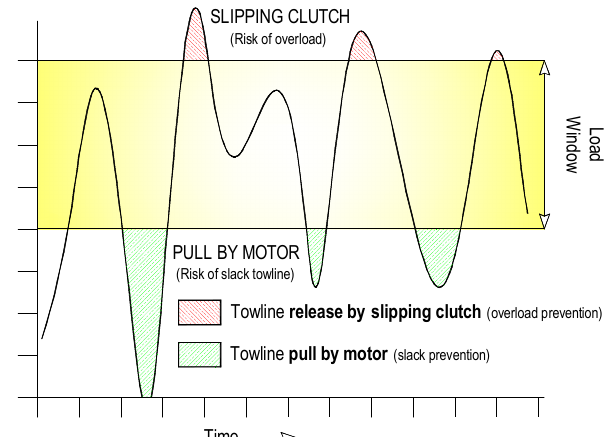
Figure 10. Typical towline load variations and SafeWinch behavior in dynamic conditions